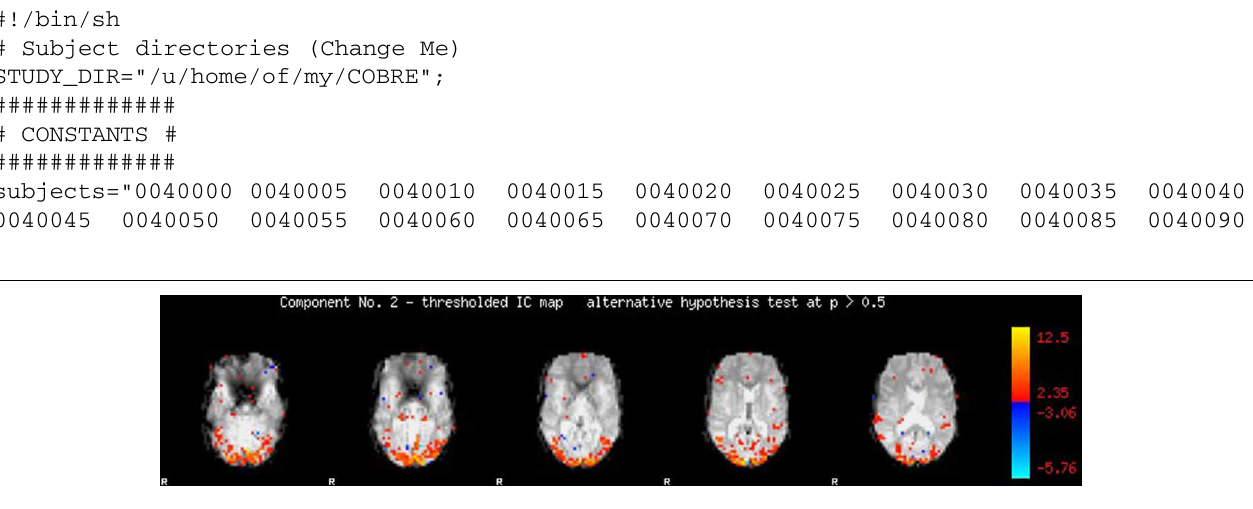
FIGURE 7 | Spatial map produced by independent components analysis in